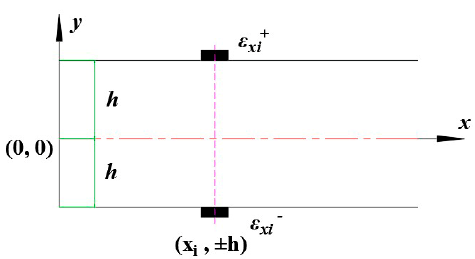
Figure 3. FBG locations within the element at ((cid:1876) (cid:3036) ,±ℎ) .